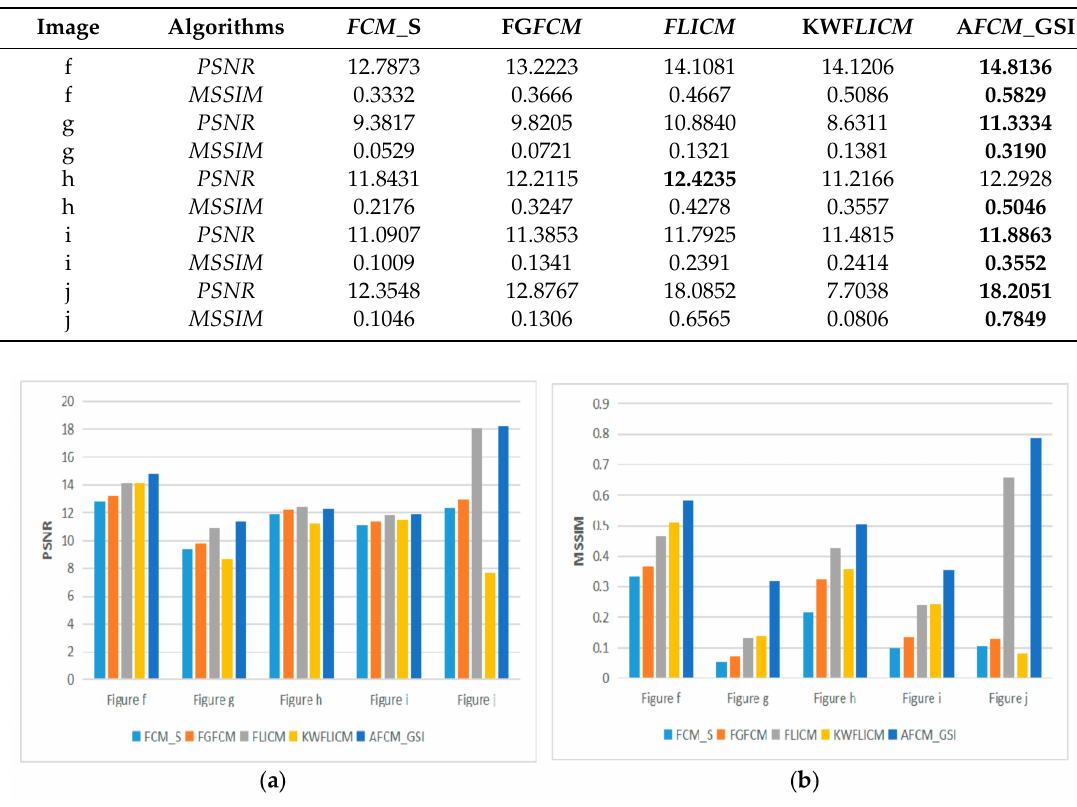
Figure 8. ( a ) Noise-free remote sensing image 2; ( b ) noise-free remote sensing image 3; ( c ) noise-free remote sensing image 4; ( d ) noise-free remote sensing image 5; ( e ) noise-free remote sensing image 6; ( f ) remote sensing image 2 polluted by synthetic noise; ( g ) remote sensing image 3 polluted by synthetic noise; ( h ) remote sensing image 4 polluted by synthetic noise; ( i ) remote sensing image 5 polluted by synthetic noise; ( j ) remote sensing image 6 polluted by synthetic noise;. Table 3. PSNR and MSSIM of five algorithms on noisy remote sensing images 2–6.